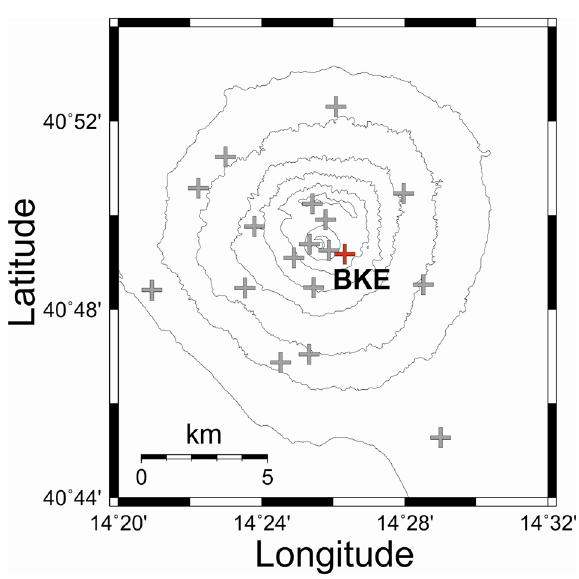
Figure 1 . Map of the monitoring seismic network of Mt. Vesuvius. The position of the BKE station, whose data have been used in this work, is shown by the red